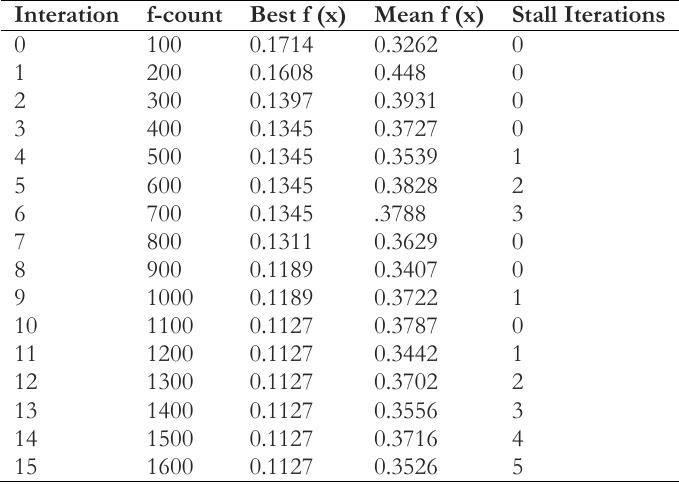
Table 3. Result of tuning the FIS using the given training data and